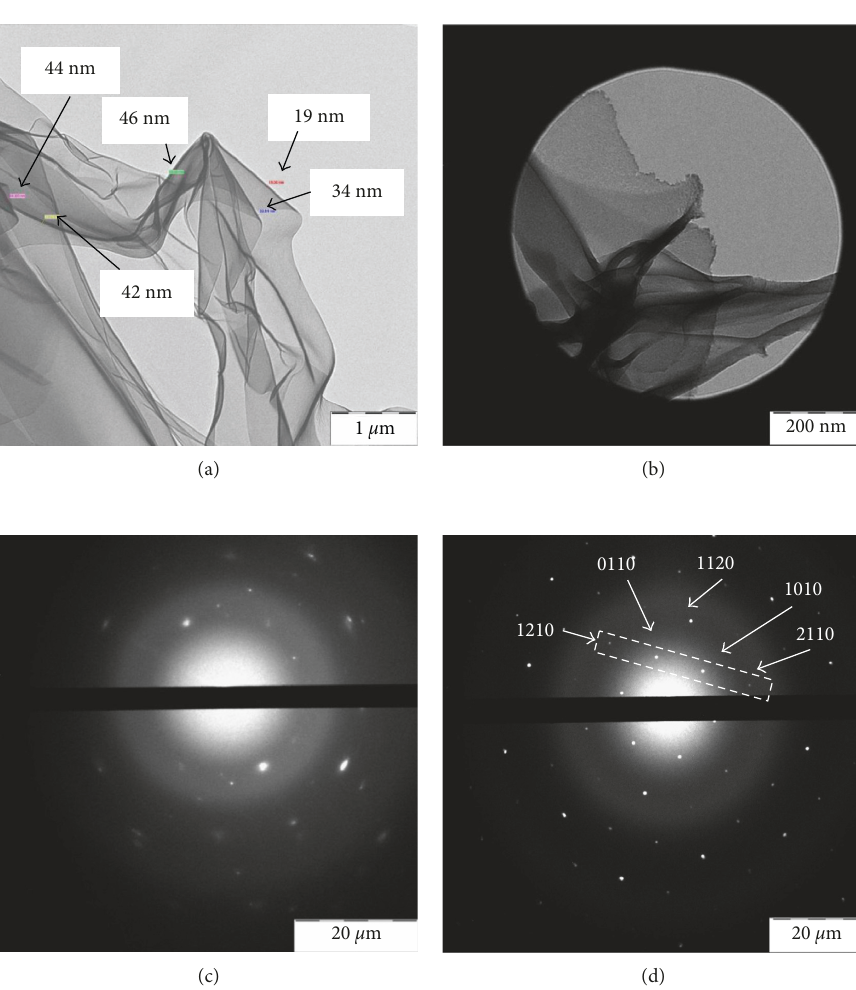
Figure 6: (a, b) TEM microphotos (in the bright and dark fields, accordingly) of graphene films obtained from the decanted liquid substance after graphene-containing colloid sedimentation during 12 hrs (Gr 1 fraction). (c, d) Electron diffraction patterns for the different regions of the